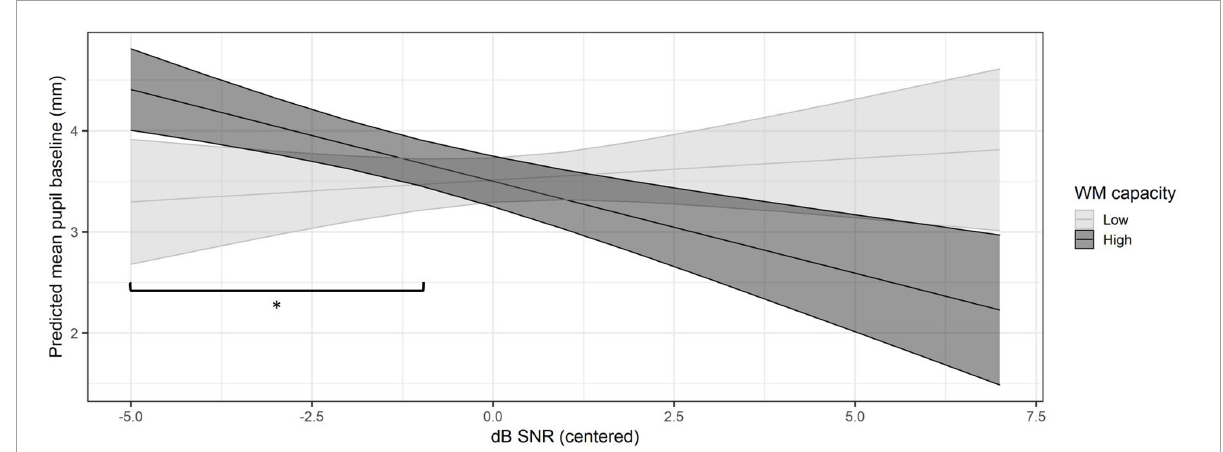
FIGURE6 Illustration of the interaction between WM capacity and signal-to-noise ratio on the predicted mean pupil baseline. The low WM capacity group is represented in light gray and the high WM capacity group in dark gray. The shaded areas show the confidence intervals at the 95%-level. ∗ Significant difference between the two WM capacity groups, p <